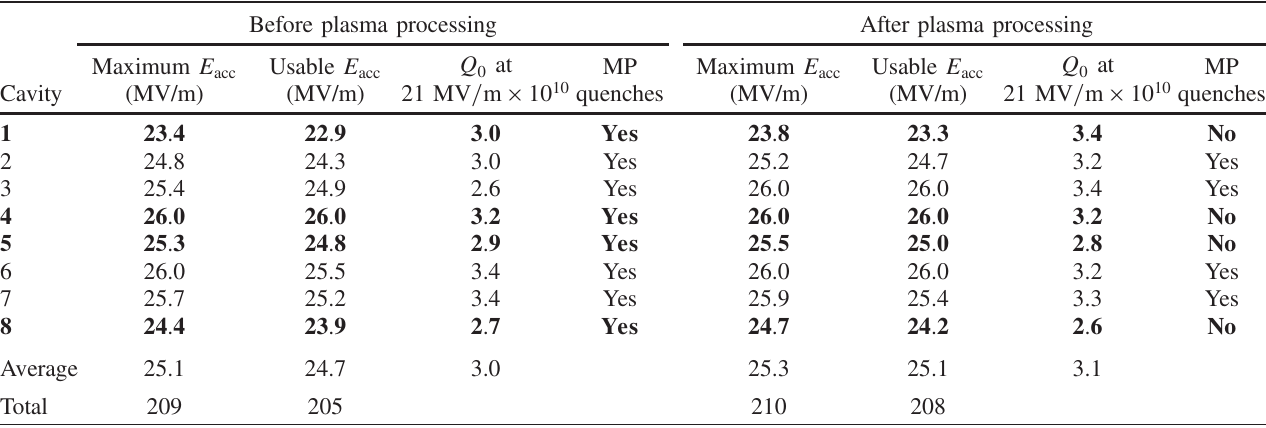
TABLE I. Comparison of vCM performance measured before and after plasma processing. The four cavities to which plasma processing was applied are highlighted in